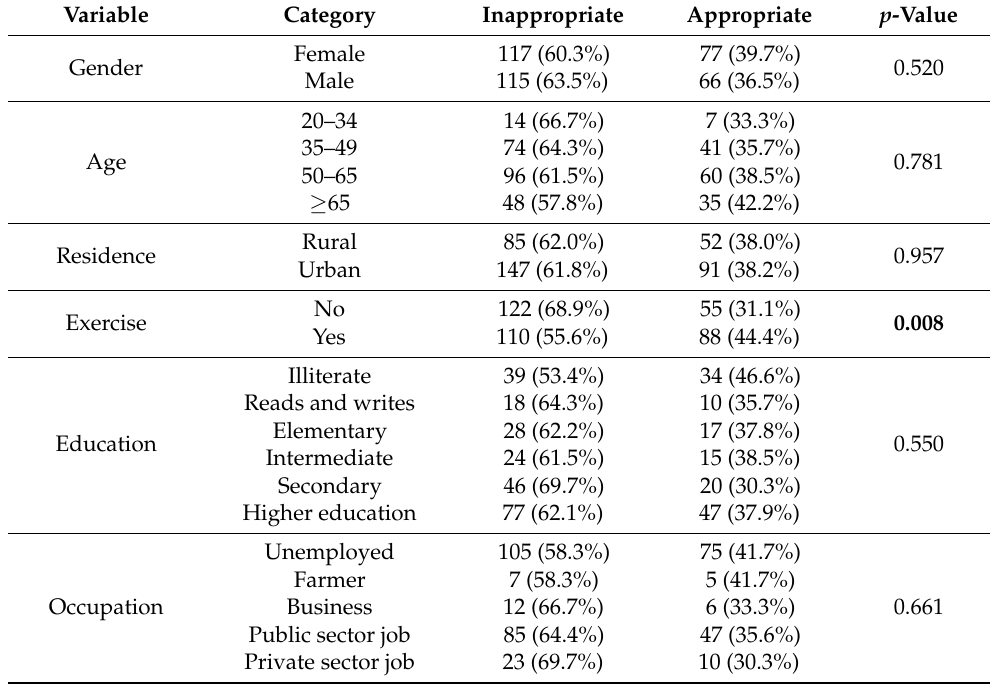
Table 4. Distribution of diabetes self-management according to the demography of participants ( n =